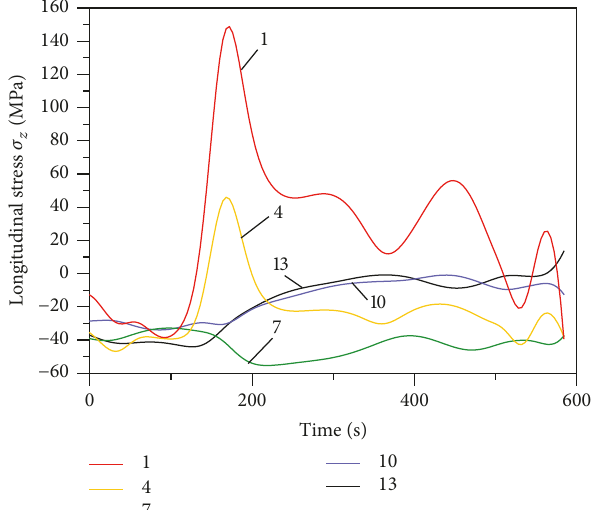
Figure 11: Longitudinal thermal stress transients in seven points on the outlet header inner surface during the faster heating